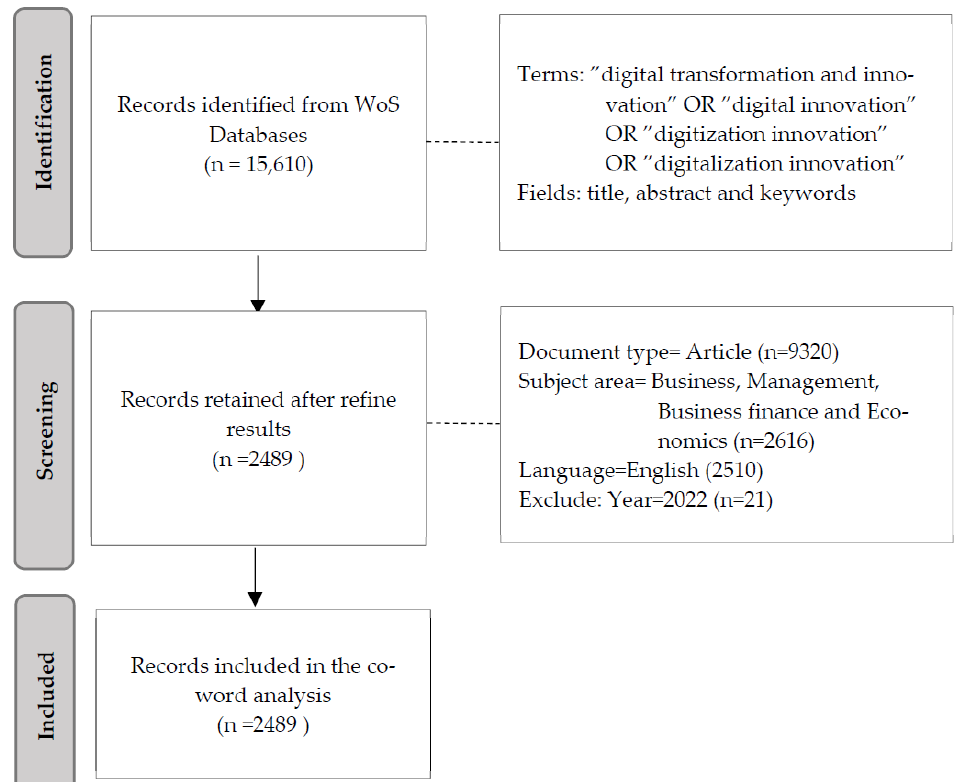
Figure 1. Process of data collection.